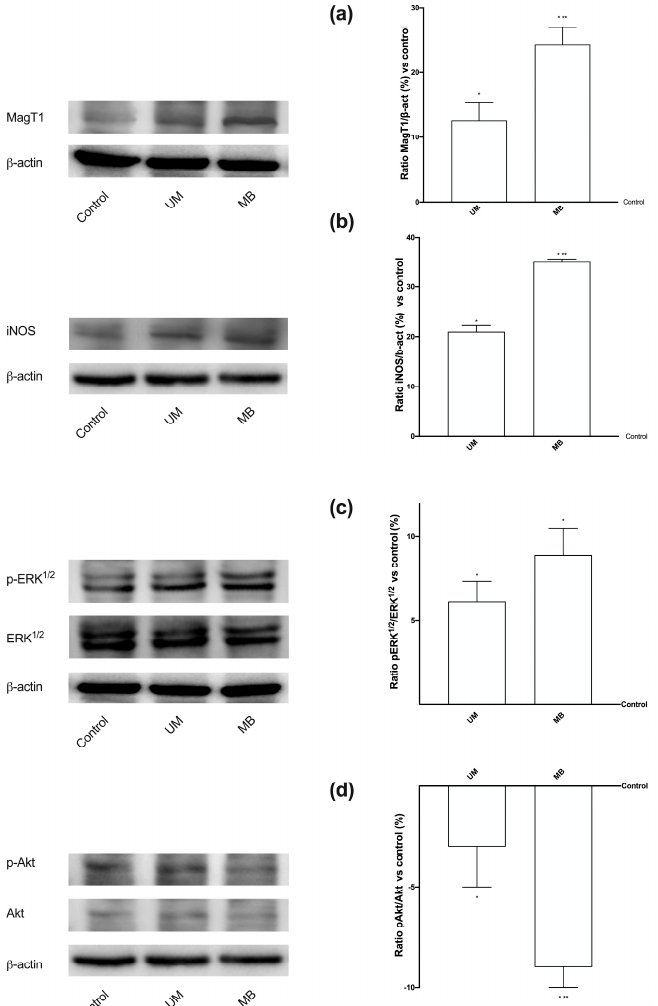
Figure 7. Western blot and densitometric analysis of some important kinases activated on PHM1-41 cells. Western blot and densitometric analysis of MagT1 ( a ), inducible nitric oxide synthase (iNOS) ( b ), ERK / MAPK ( c ), and PI3K / Akt ( d ), analyzed on whole PHN1-41 lysates at 3 h of stimulations. The images reported are an example of each protein from five independent experiments reproduced in triplicate. Data are expressed as means ± SD (%) of five independent experiments normalized on specific total protein if possible and verified on β -actin detection. * p < 0.05 vs. control; ** p < 0.05 vs. UM. The abbreviations are the same as reported in Figure